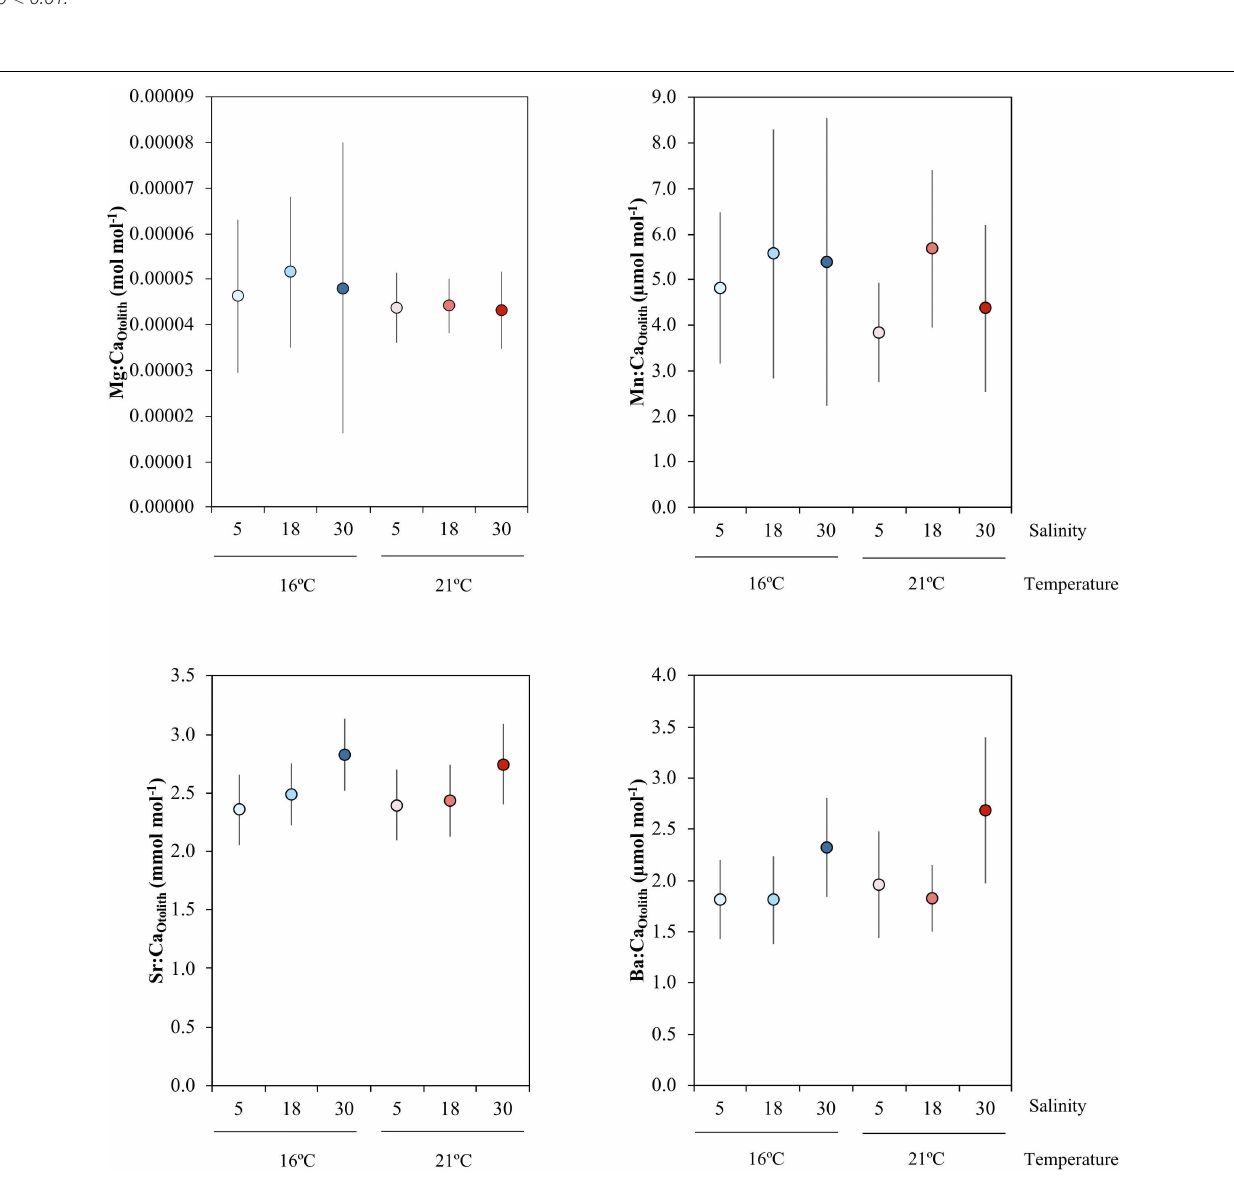
FIGURE 2 | Mean and standard error of Mg:Ca Otolith , Mn:Ca Otolith , Sr:Ca Otolith , and Ba:Ca Otolith across the salinity (5, 18, 30) and temperature (16 and 21 ◦ C) experimental treatments, which are indicated by the different colors: blue colors – 16 ◦ C, red colors – 21 ◦ C; light tone – 5 salinity, medium tone – 18 salinity, dark tone – 30